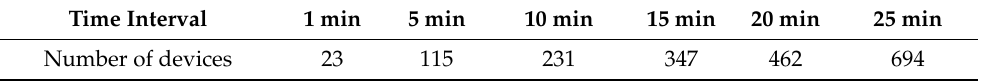
Table 6. Table of potential requests at different time intervals in order to not exceed the free limit. Time